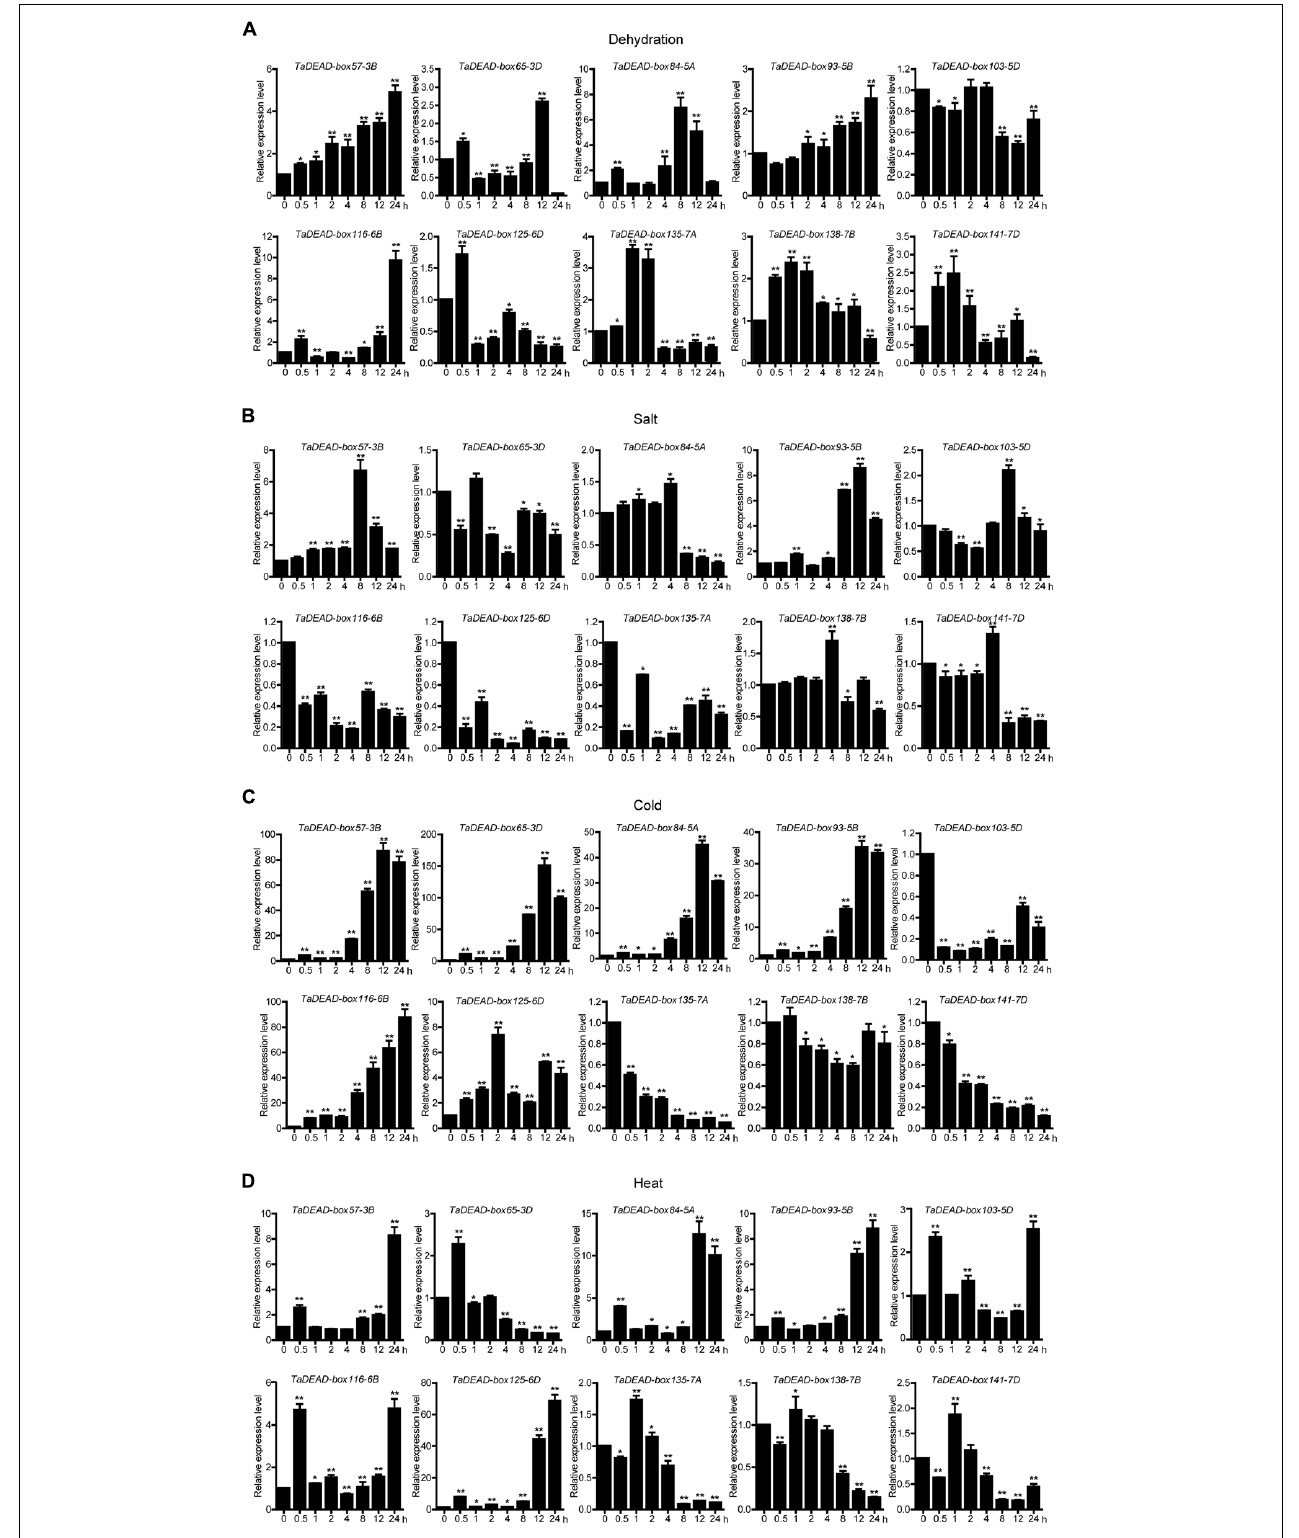
FIGURE 7 | Quantitative Real-Time PCR (qRT-PCR) analysis of 10 TaDEAD -box genes under dehydration (A) , salt (B) , cold (C) and heat (D) treatments. Seven-day-old wheat seedlings were used for dehydration (250 mM Mannitol), salt (200 mM NaCl), heat (42 ◦ C), and cold (4 ◦ C) stress treatments. The wheat β -actin was used as an internal control. The data represent means ± SD of three biological replications. ANOVA test was used to analyze significant differences (* p < 0.05, ** p < 0.01).